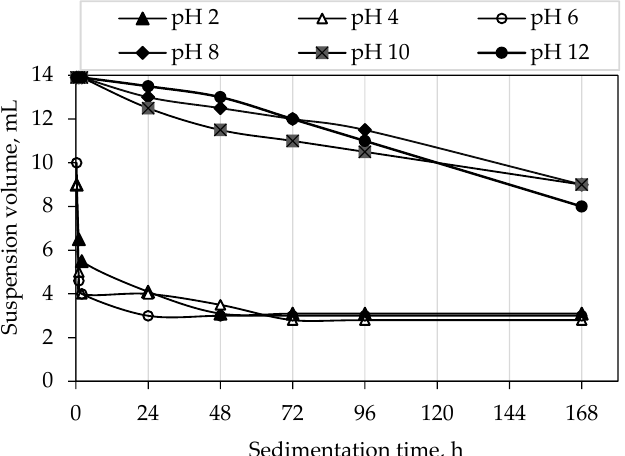
Figure 7. Sedimentation rate of water-based alumina suspensions with optimal composition after 168 h (7 days).